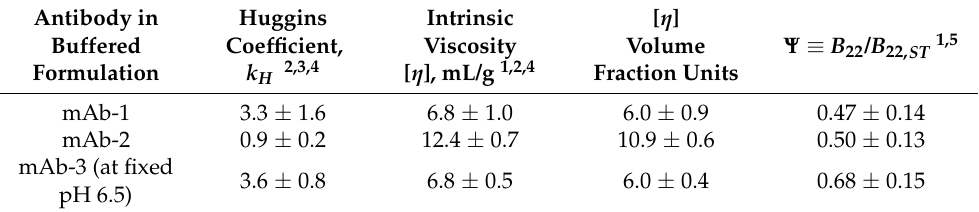
Table 3. Experimentally determined values of Huggins coefficient k H , intrinsic viscosity [ η ], and osmotic second virial coefficient B 22 at 25 ◦ C for mAbs.